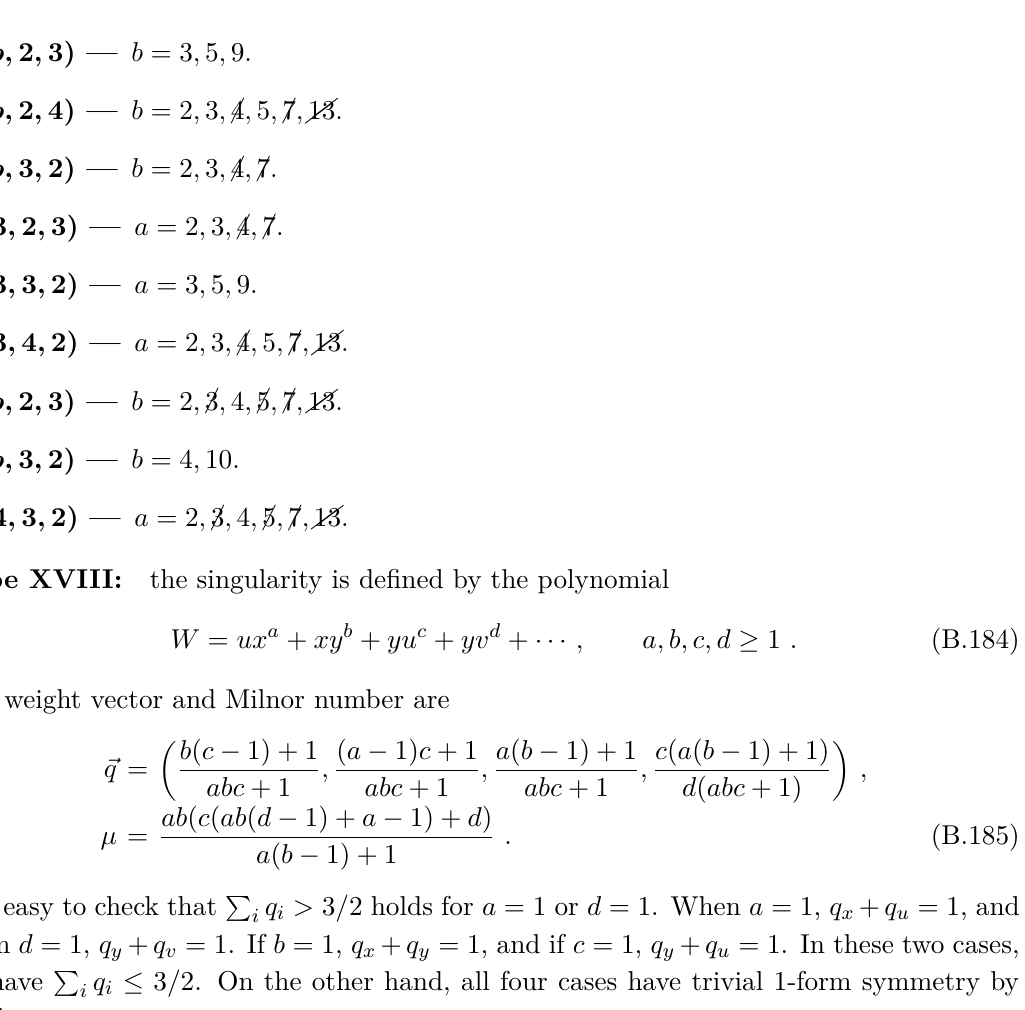
Table 21 . Infinite sequences of type XVII singularities. The gray entries are either reducible to previous types or have at least one of c, d = 1 , which gives trivial 1-form symmetry. This table is adapted from